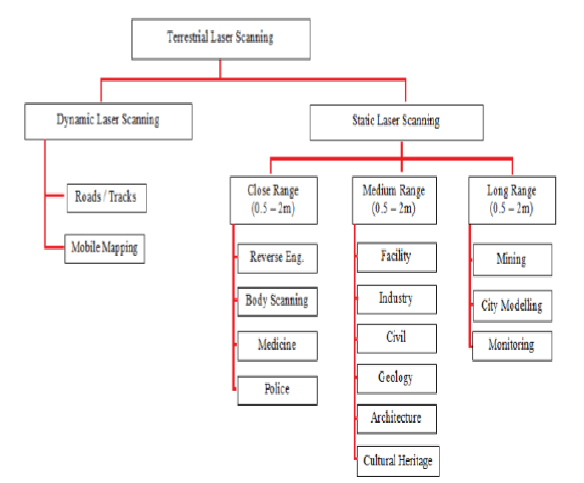
Figure 1. Applications of Terrestrial Laser Scanning (Giussani et al.,